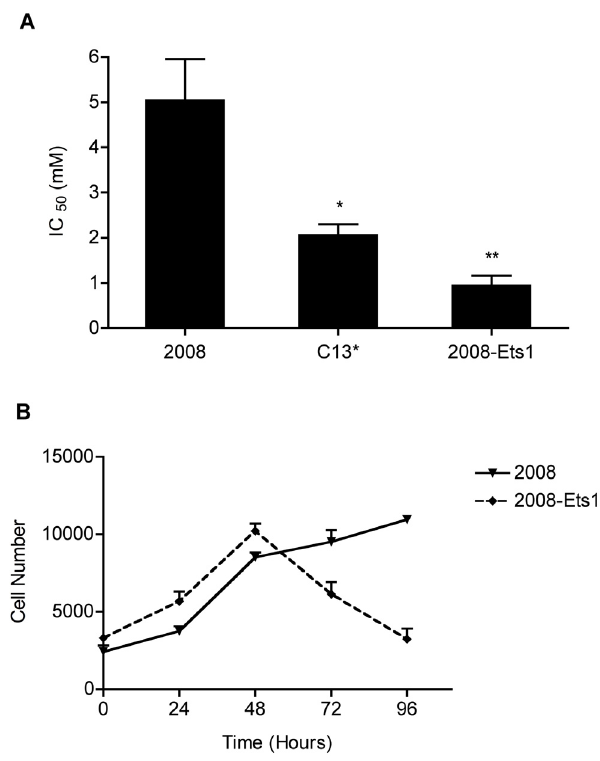
Figure 3. Glycolytic dependence of Ets-1-expressing ovarian cancer cells. ( A ) 2008, C13*, and 2008-Ets1 cells were treated with the glycolytic inhibitor 2-DG, and cellular growth was measured following 96 hours of incubation. 2008-Ets1 and C13* cells which express Ets-1 showed significantly decreased growth following glycolytic inhibition in 2008-Ets1 compared to parental 2008 cells (n=4). ( B ) 2008 and 2008- Ets1 cells were grown in the absence of glucose, and proliferation assays were conducted at 24 hour intervals. 2008-Ets1 ovarian cancer cells expressing high levels of Ets-1 showed a decreased ability for growth in glucose-free culture medium, suggesting an increased reliance on glycolysis for energy (n=3).